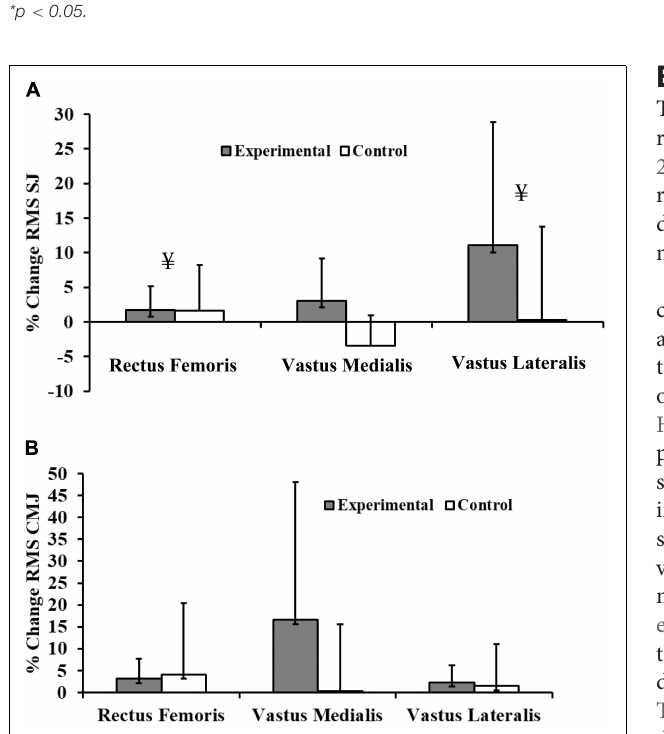
FIGURE 4 | Percentage change of root mean square (RMS) EMG voltage during (A) Squat Jump (SJ) and (B) Counter-Movement Jump (CMJ) in rectus femoris (RF), vastus medialis (VM), and vastus lateralis (VL) muscles for experimental and control subjects after participation of experimental subjects in the 8-week plyometric training program. (cid:85) ANOVA: A two-way analysis of variance (group × time) assessed the statistical significance of training-related effects: p <